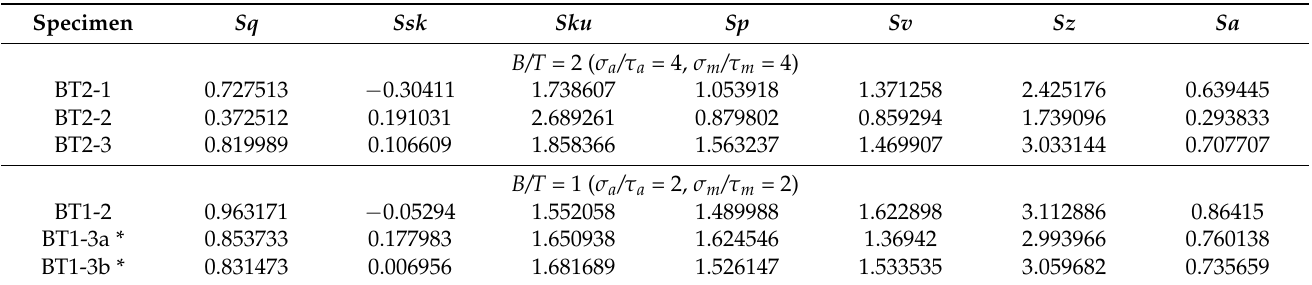
Table 6. Summary of the Sx results.